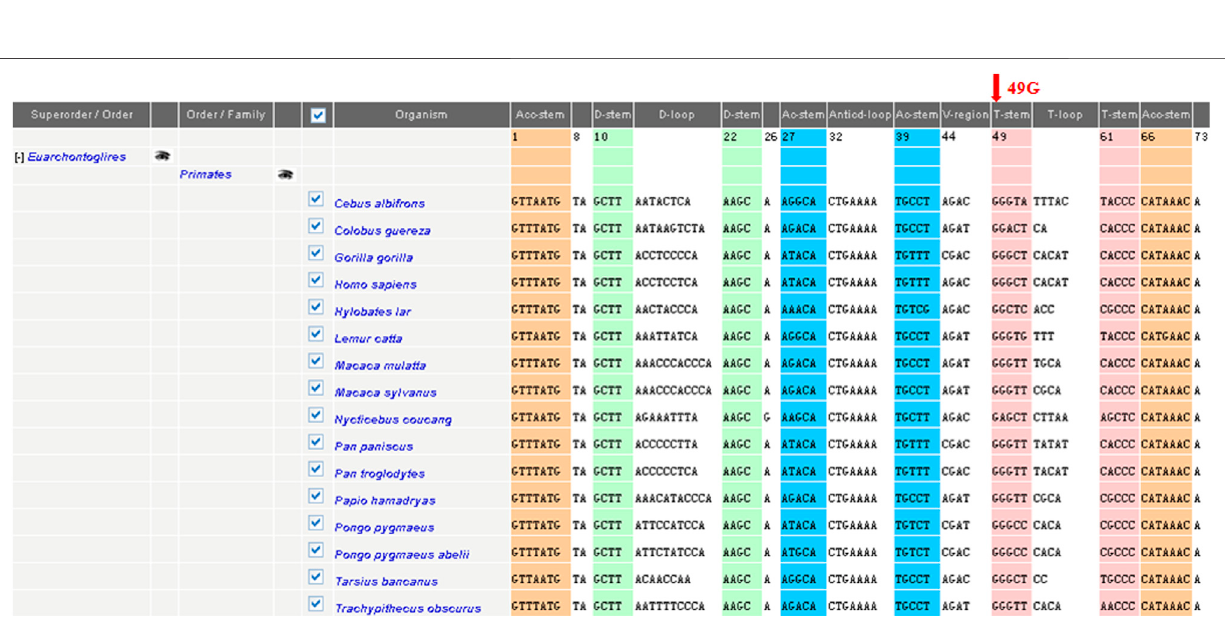
Frontiers in Genetics |